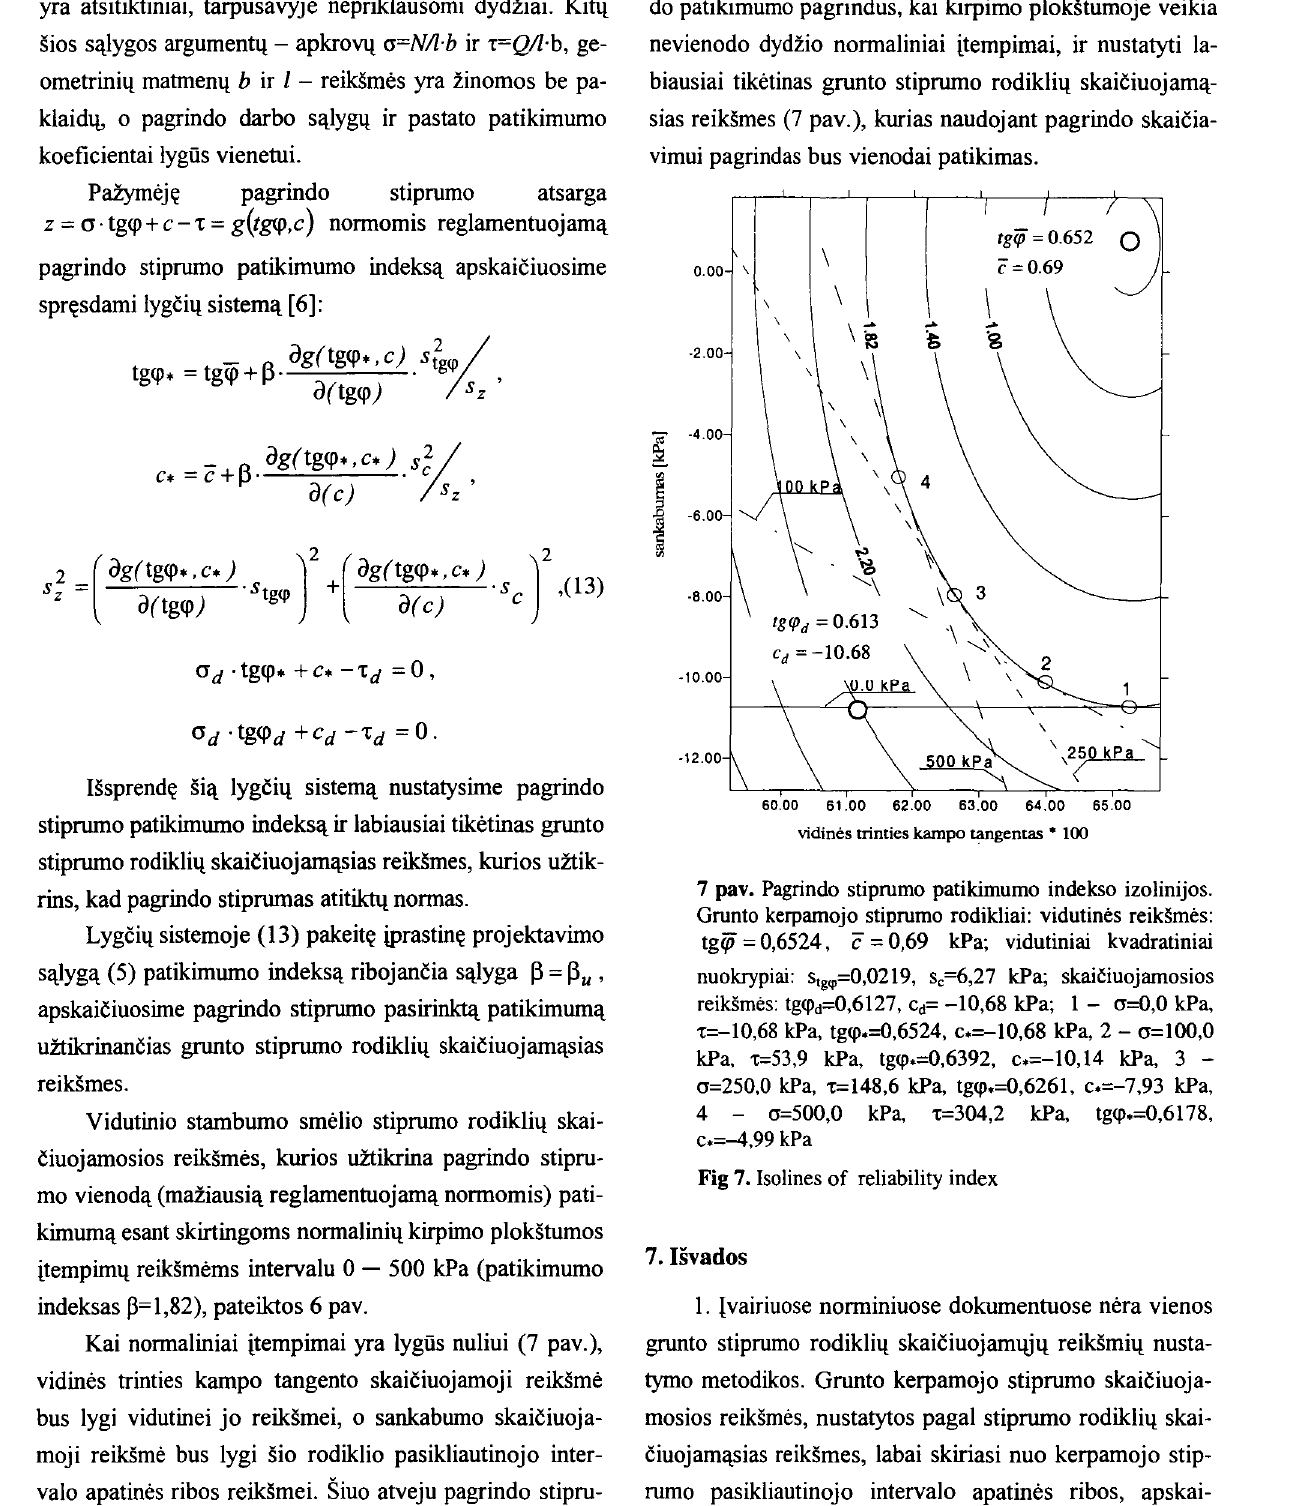
Fig 7. Isolines of reliability index 7.